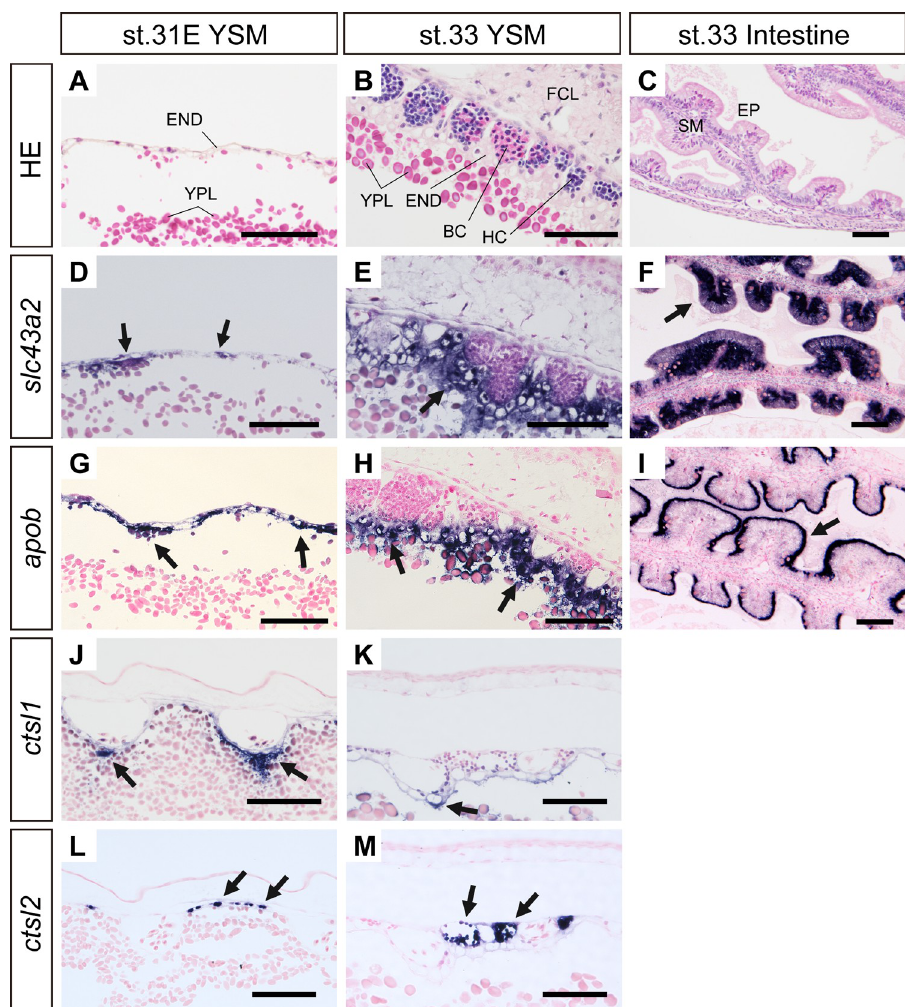
Fig 6. Localization of the mRNAs involved in lipid absorption and lysosomal digestive enzyme in the yolk sac membrane. Morphological observations of the YSM shown by hematoxylin and eosin staining (A-C). In situ hybridization staining of slc43a2 (D-F), apob (G-I), ctsl1 (J, K), and ctsl2 (L, M). Arrows indicate the positive signals. END, endoderm; EP, epithelial cells; FCL, fibrous connective layer; HC, hematopoietic cell; SM, submucosa; BC, blood cells. Bars, 100 μ